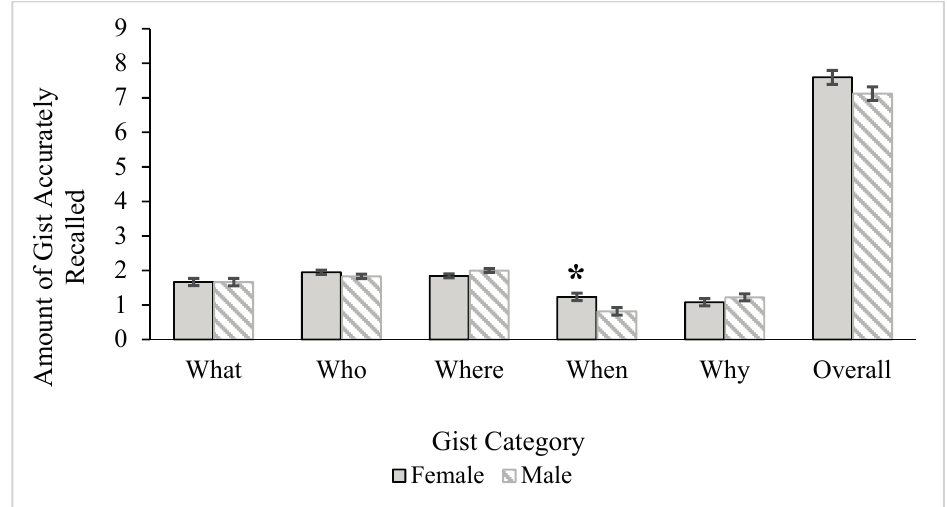
Figure 2. Gender differences for overall accuracy of gist and gist categories. Error bars represent ± 1SE. Asterisk marks significant effect at the p < 0.01 level. Gender differences remained significant after including covariates (episodic memory, education) in the